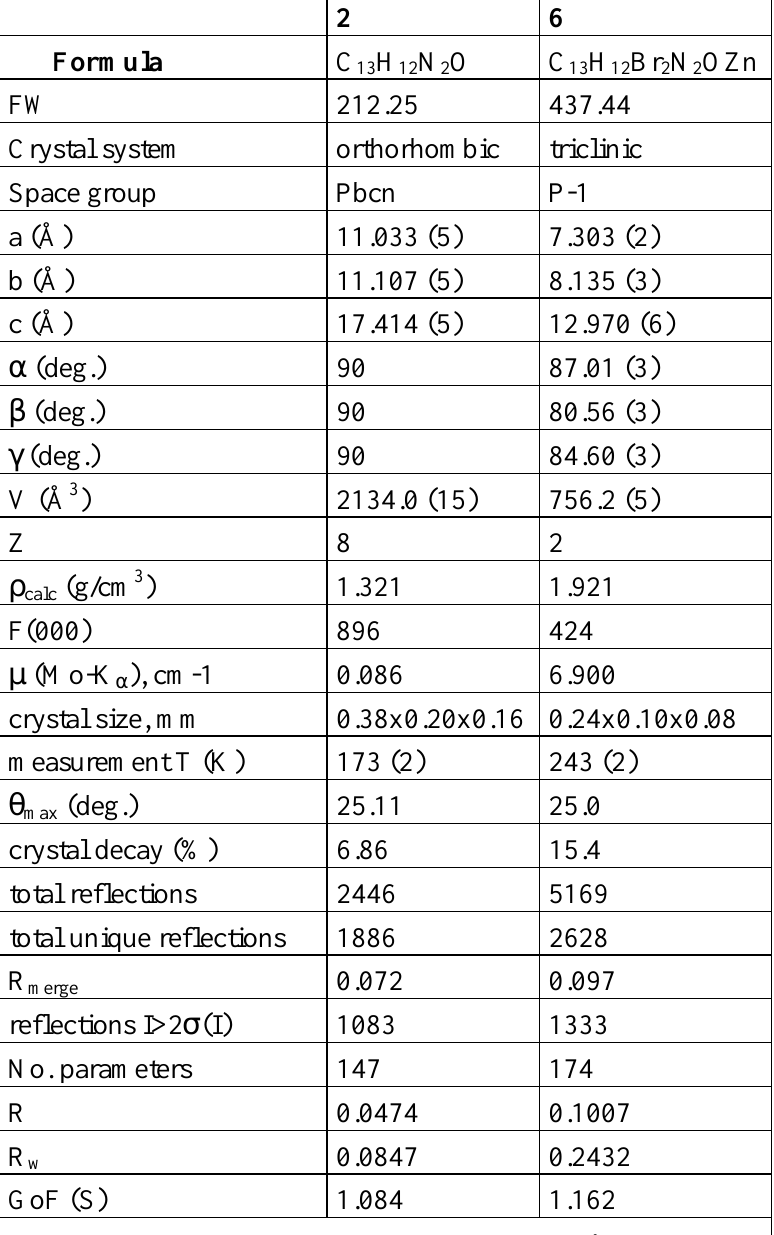
Table 1. Selected X-ray acquisition data for 2 and 6